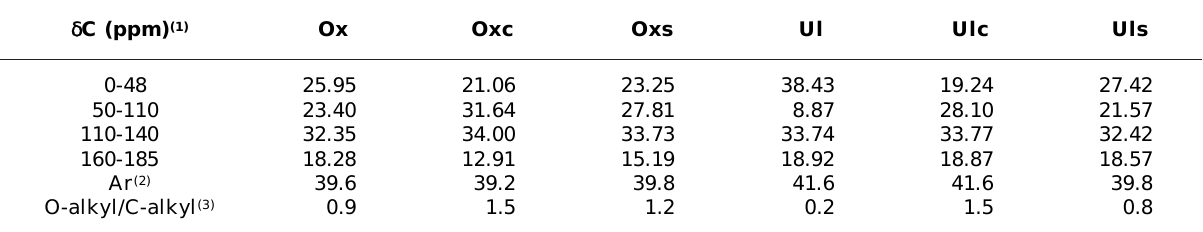
Table 2. Relative percentage peak areas in the NMR 13 C spectra from humic acids extracted from ultisol (Ul) and oxisol (Ox) with municipal compost (Ulc and Oxc) and sewage sludge (Uls and Oxs)